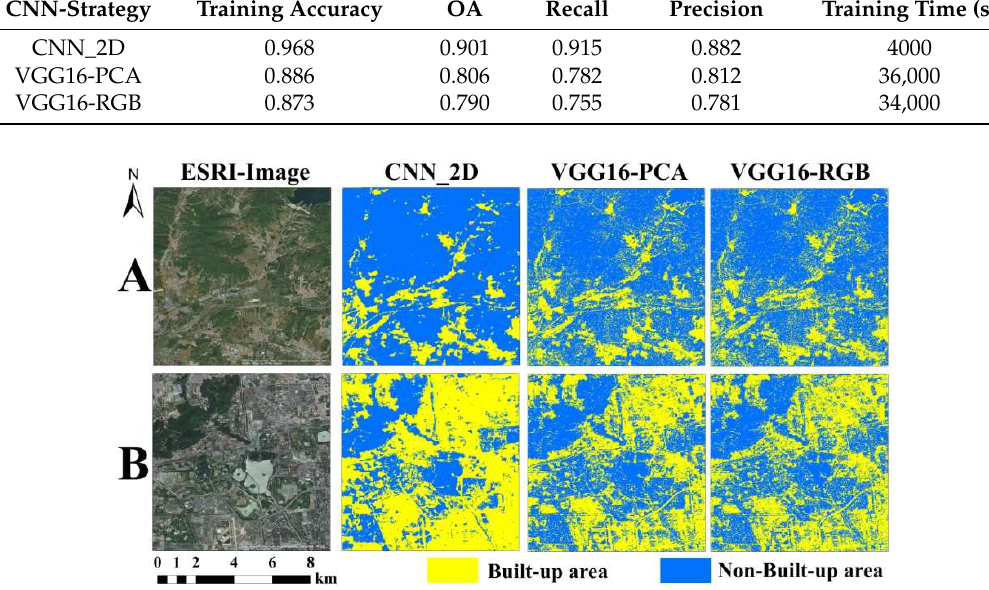
Figure 14. Results of built-up area by CNN_2D, VGG16-PCA, and VGG16-RGB (A and B represent the two subregions. The first column is the online images of ERSI. The second column represents the classification results of CNN_2D. The third and fourth columns represent the classification results of VGG16-PCA and VGG16-RGB, respectively.)